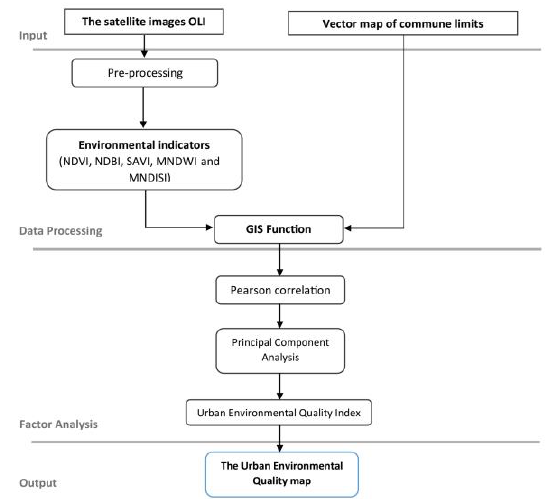
Figure 2 . Flowchart representing the research design